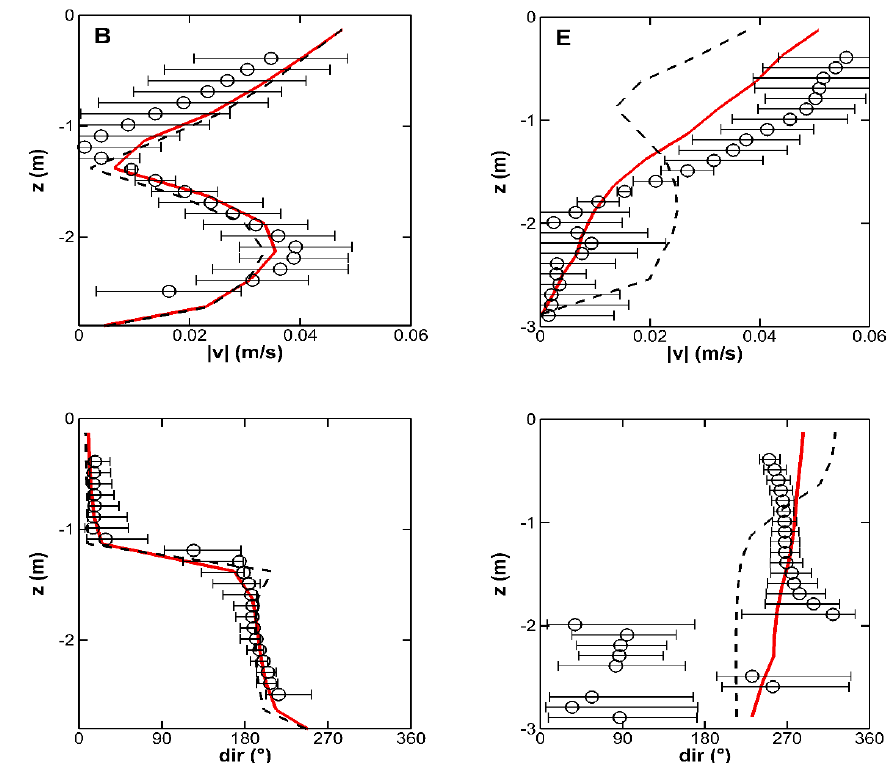
Figure 6. Comparison of velocity profiles between field observations (circles) with error bars and modelled results with (solid red lines) and without (black dashed lines) littoral macrophytes at location B in the pelagic area and location E in the littoral zone. The upper panel shows velocity magnitudes and the lower panel shows directions.